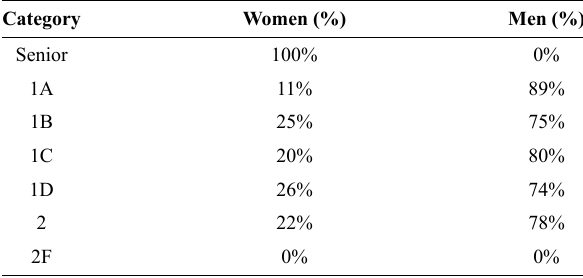
Table 2 - Productivity scholarship category by